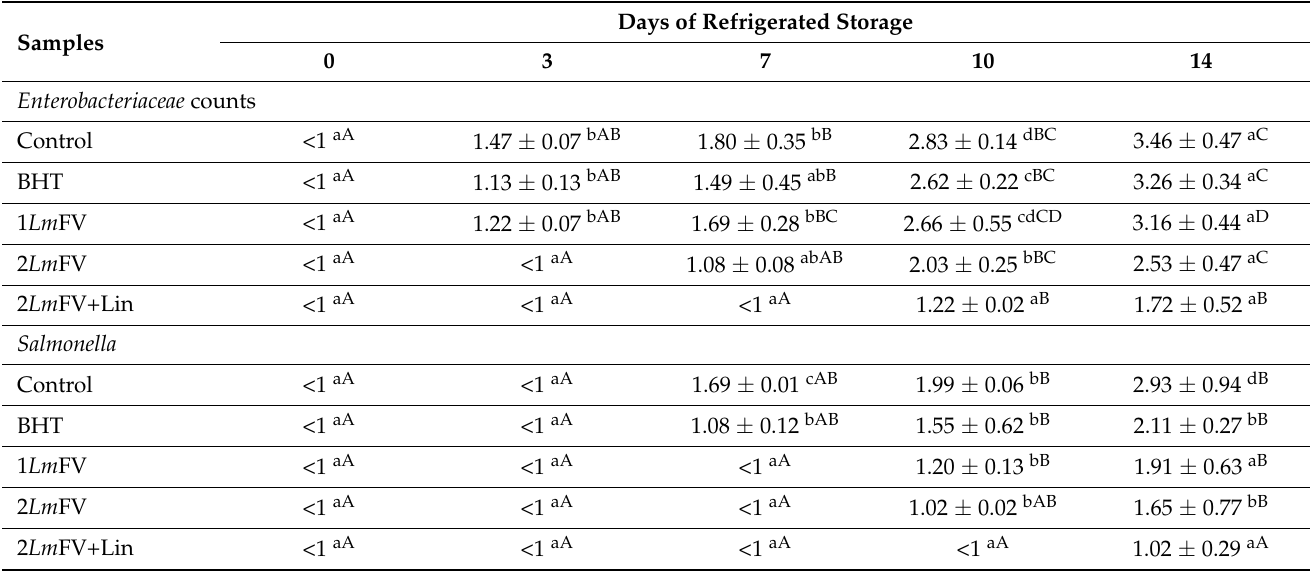
Table 5. Enumeration of Enterobacteriaceae and Salmonella in various samples of raw ground beef stored at 4 ◦ C for 14 days.